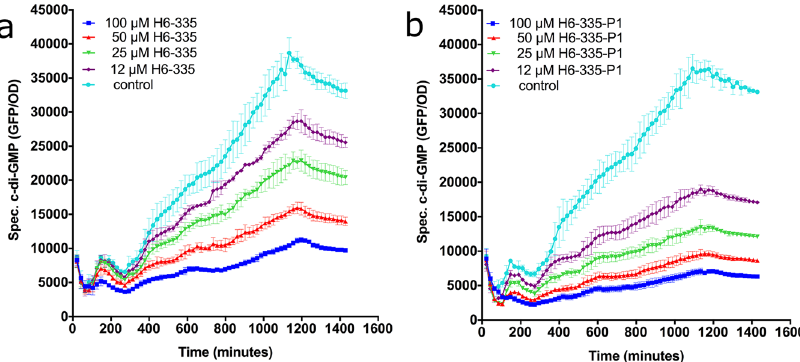
Fig. 1 H6-335 and H6-335-P1 reduce the c-di-GMP content in P. aeruginosa . Effects of H6-335 ( a ) and H6-335-P1 ( b ) on the fl uorescence output of the c-di-GMP monitor strain P. aeruginosa Δ wspF Δ pel Δ psl/ pCdrA-gf p . Bacteria were grown in the wells of microtiter plates in the presence of various concentrations of H6-335 or H6-335-P1. GFP fl uorescence was measured every 20 min for 24 h. Speci fi c c-di-GMP levels (GFP/OD